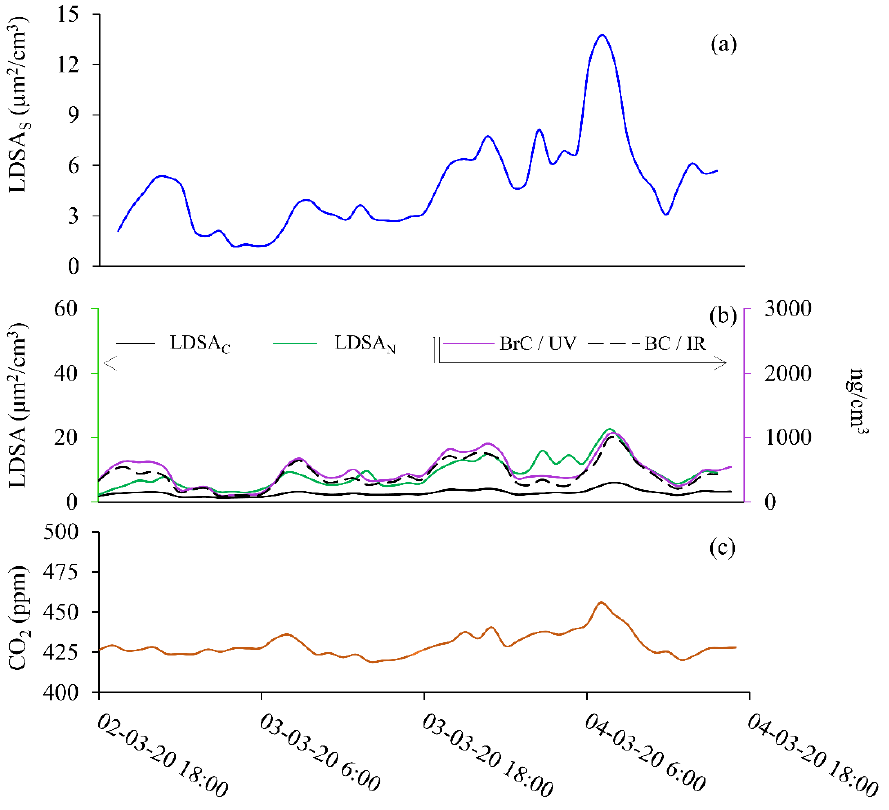
Figure 5. Semi-volatile particle event during 2nd March 2020 at 18:00 to 4th March 2020 at 18:00. Data shown for ( a ) SMPS (LDSA S ), ( b ) LDSA N and LDSA C (left axis), BC and BrC (right axis), and ( c ) CO 2 .